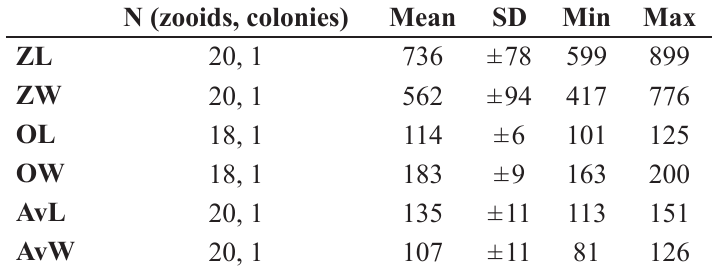
Table 9. Measurements in µm of Microporella sp. 1, Recent, Puysegur Bank, New Zealand; voucher specimen BLEED 151.